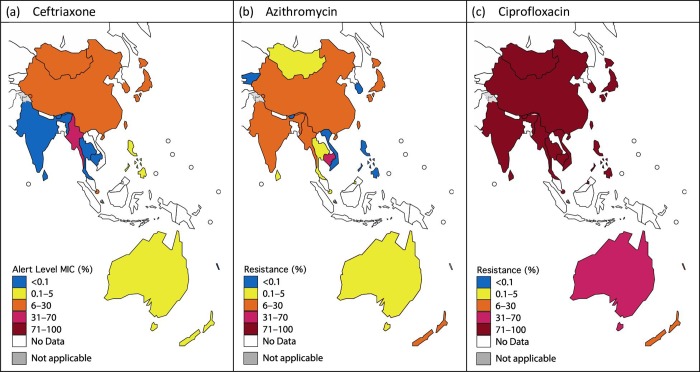
Mapping ranges for ceftriaxone, azithromycin and ciprofloxacin in the WPR and SEAR for 2016 based on surveillance data submitted to the Gonococcal Antimicrobial Surveillance Programme.(a) Ceftriaxone: Proportion of strains with MIC ≥ 0.125 mg/L; (b) Azithromycin: Proportion of strains with MIC ≥ 1 mg/L; (c) Ciprofloxacin: Proportion of strains with MIC ≥ 1 mg/L. Countries with data included irrespective of number of samples available. Countries without data excluded. Australian colouration is based on non-remote data. Ranges for Cambodia and Myanmar are based on limited (≤ 10) isolates.